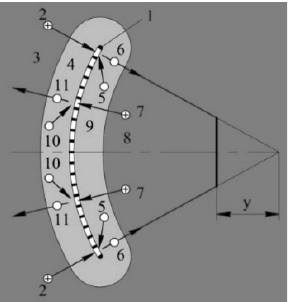
Fig. 2. Generation of compressed beam of fast atoms using a grid with concave surface.